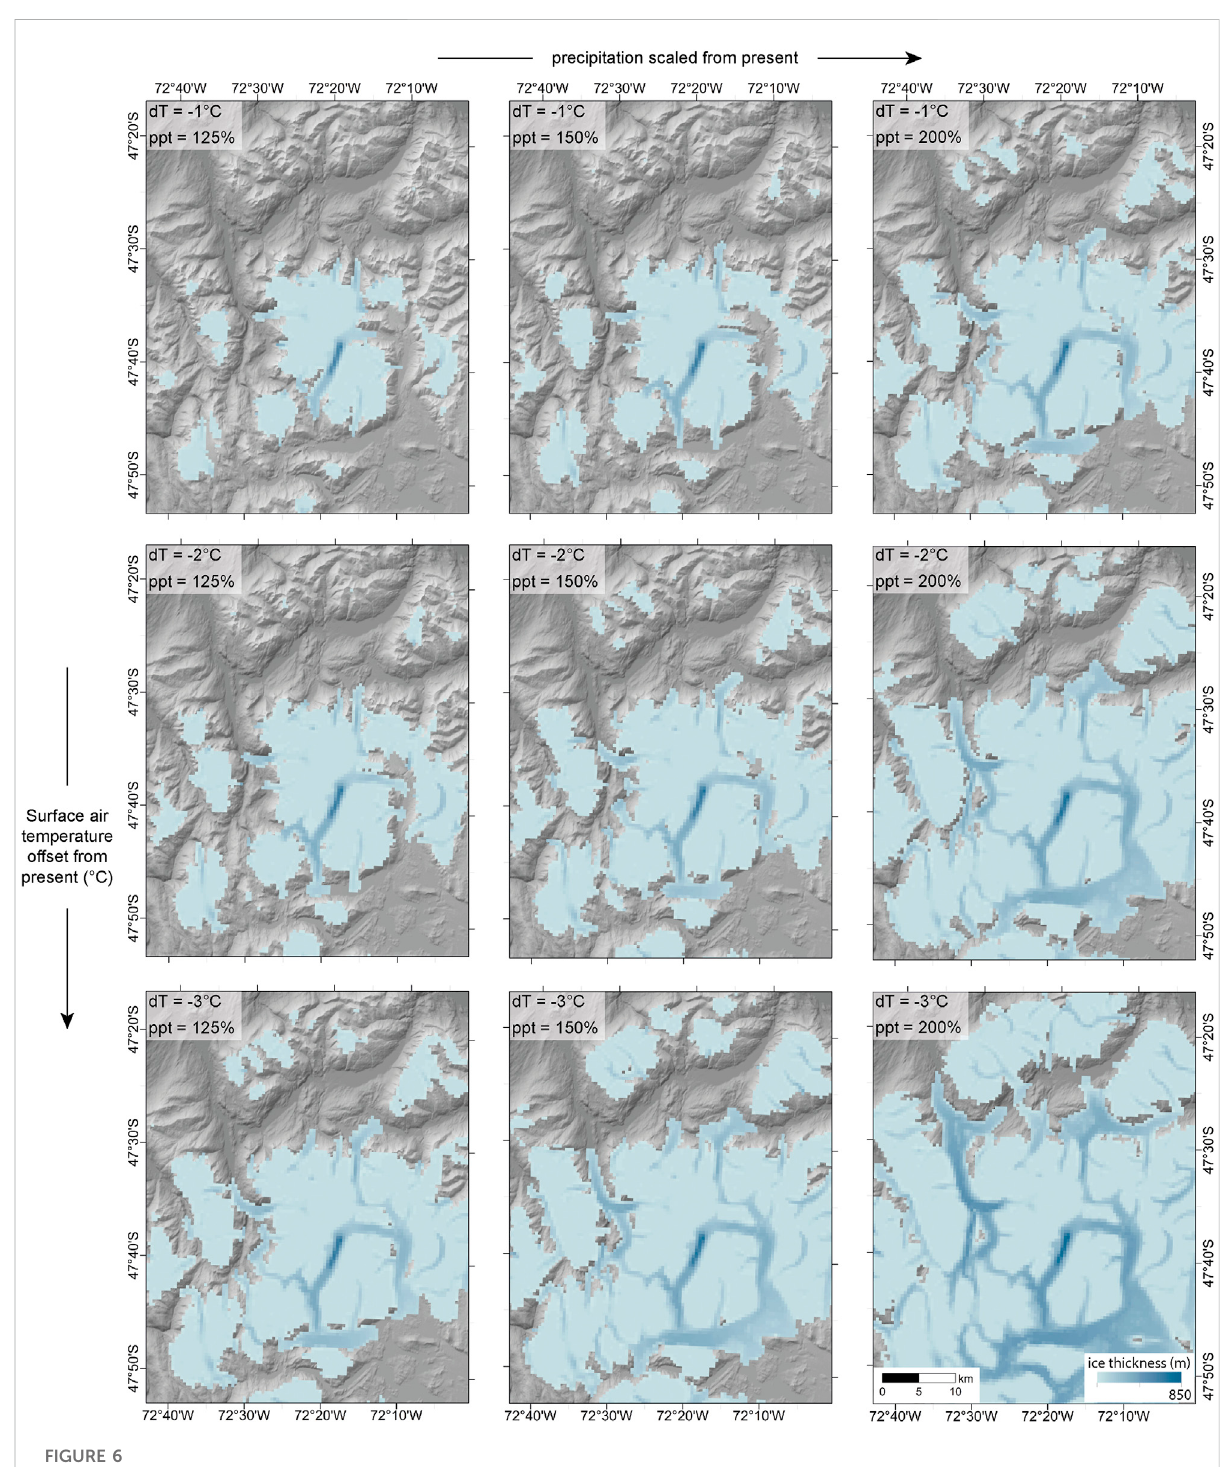
FIGURE 6 ExperimentG.Model simulationsoftheMSLicecapundercombined surfaceair temperaturestep cooling of1 – 3 ° C andprecipitationscalingof 125% –